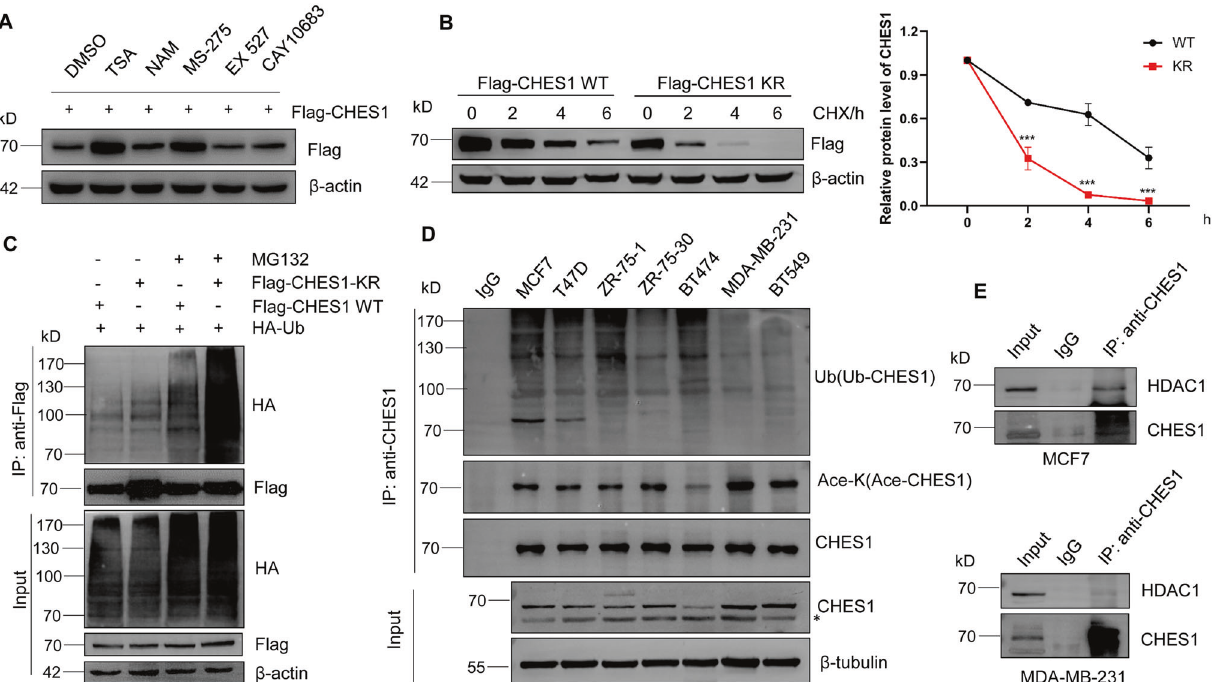
Fig. 5 Acetylation of CHES1 enhanced its protein stability via decreasing its ubiquitination. A The effect of HDACs inhibitors on the protein levels of exogenous CHES1. B Western blot showed the half-life of wild type CHES1 and its KR mutant after treating with 10 μ g/ml